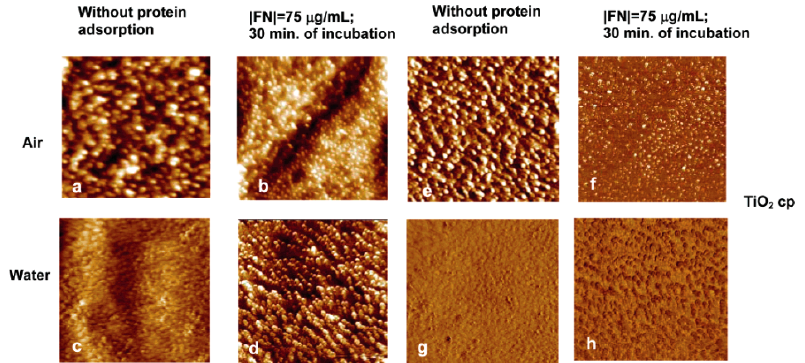
Figure 3. AFM height ( a – d ) and corresponding phase ( e – h ) images of TiO 2 recorded in air and water before and after protein adsorption. Reprinted from Ref. [74] with permission from American Chemistry Society.